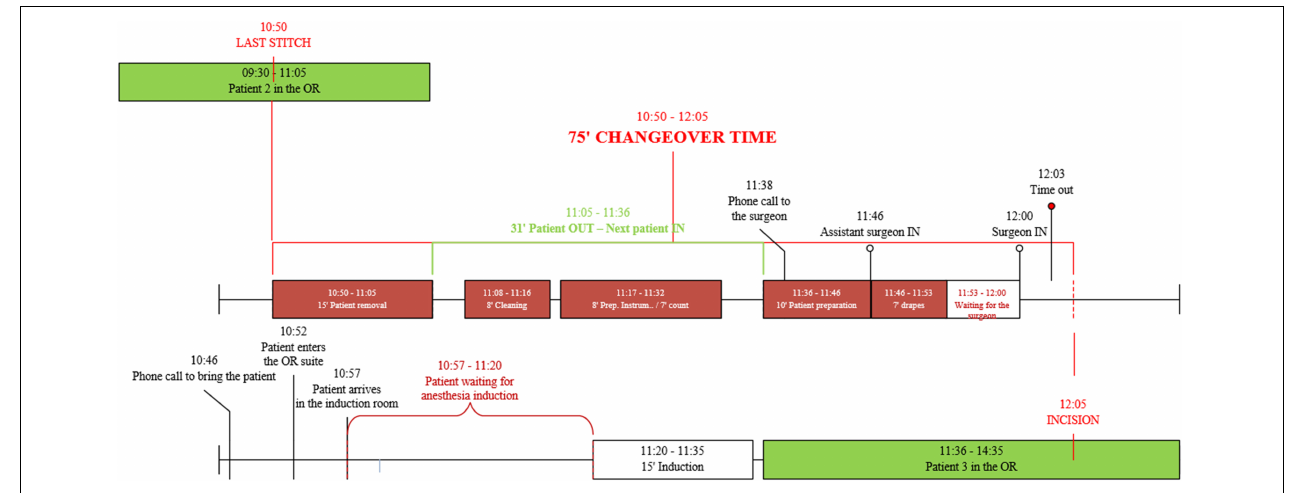
FIGURE 1 | Cause-effect diagram of factors affecting changeover